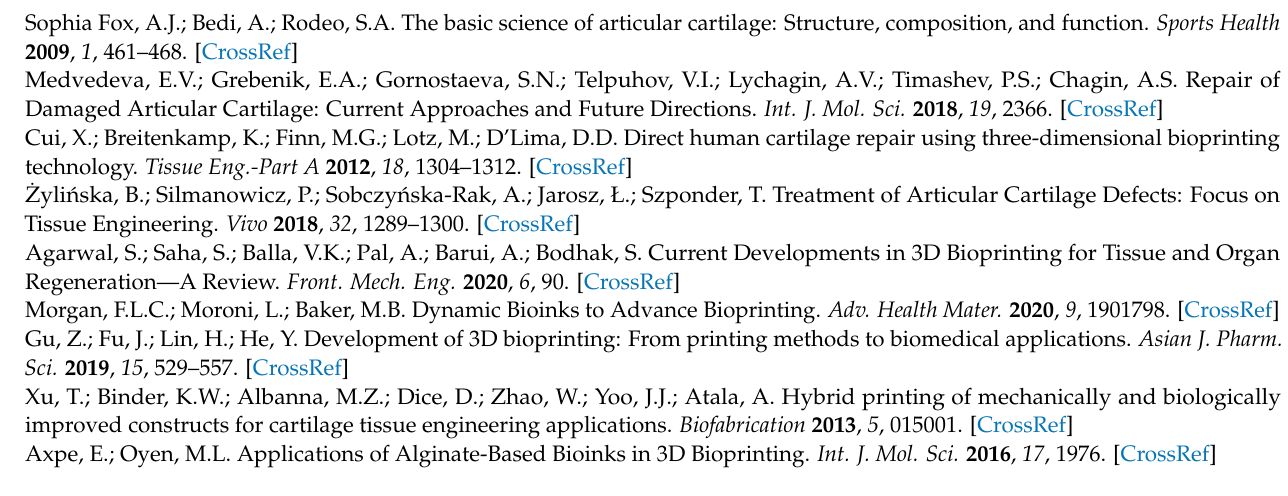
Figure S3: Oscillation amplitude sweep (0.1–100%) of F8: [4% CNC: 4% Alg: 40% PEGDA] hy- drogel with a fixed frequency of 1 Hz. Figure S4: Oscillation amplitude sweep (0.1–100%) of F9: [2% CNC: 2.5% Alg: 25% PEGDA] hydrogel with a fixed frequency of 1